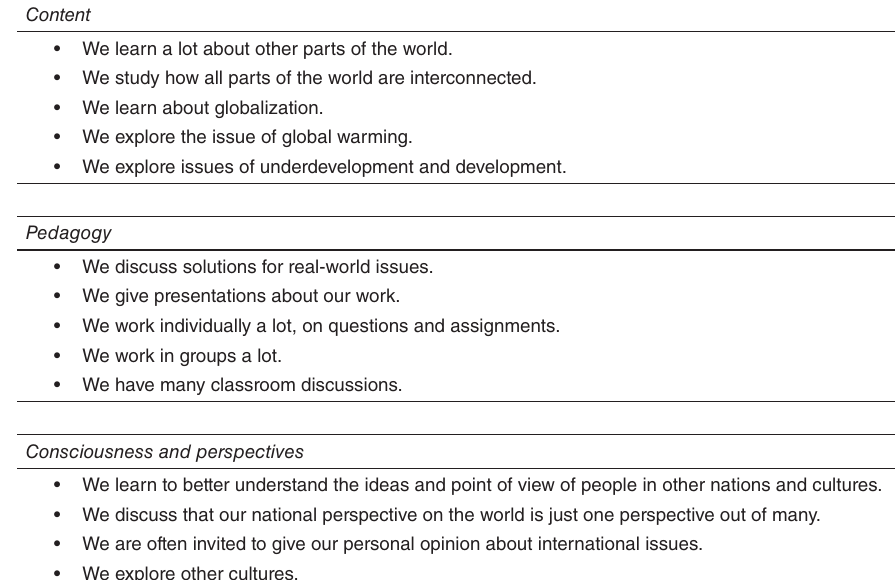
Table 2: Questionnaire statements to evaluate geography